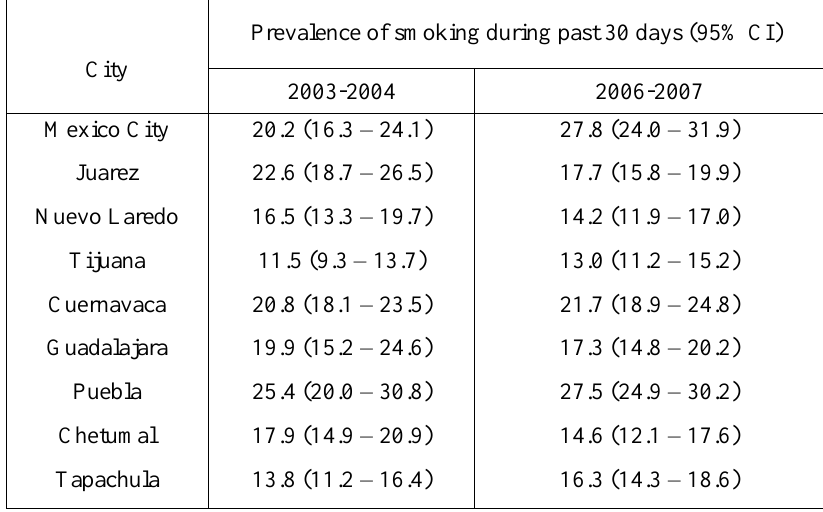
Table 2. Smoking prevalence among Mexican adolescents. GYTS 2003-2004 and 2006-